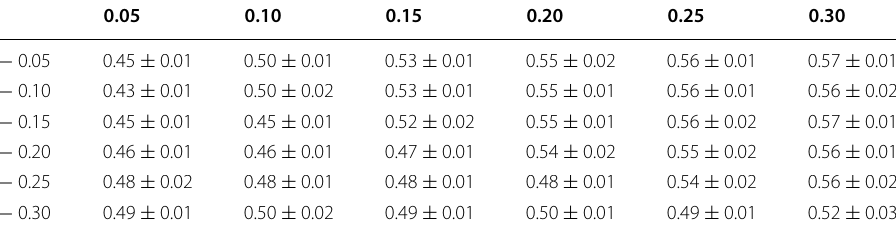
The first row shows the φ